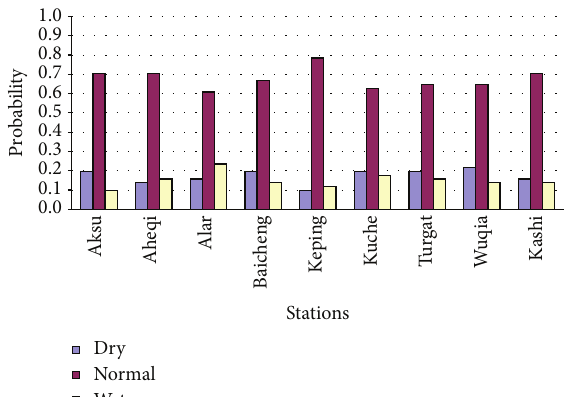
Figure 4: Distribution in percentage of dry, normal, and wet years for the 9 synoptic stations during the period 1960–2010.